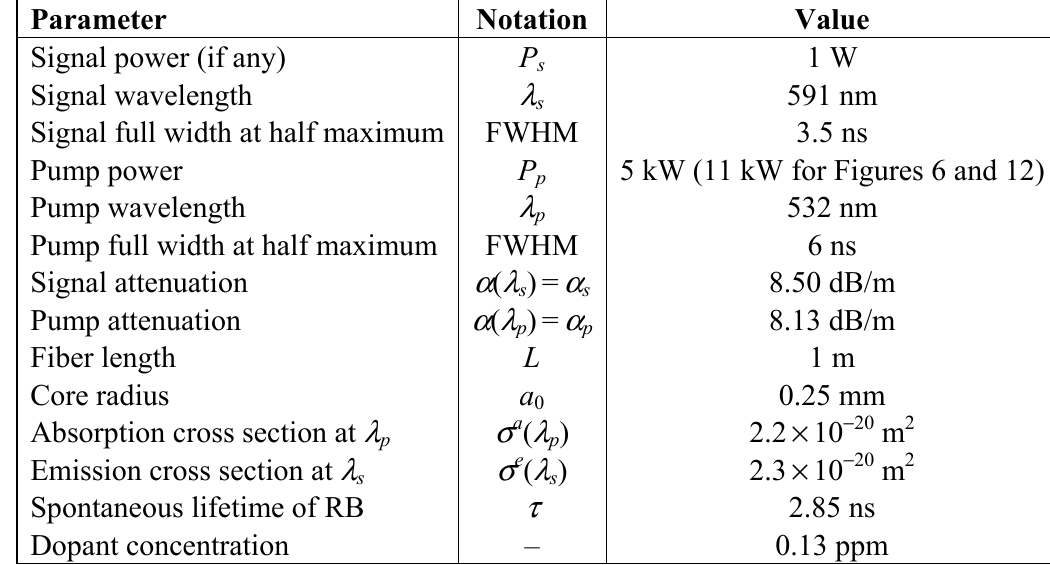
Table 2. Parameters used for the simulations of SI and GI POF lasers and amplifiers doped with